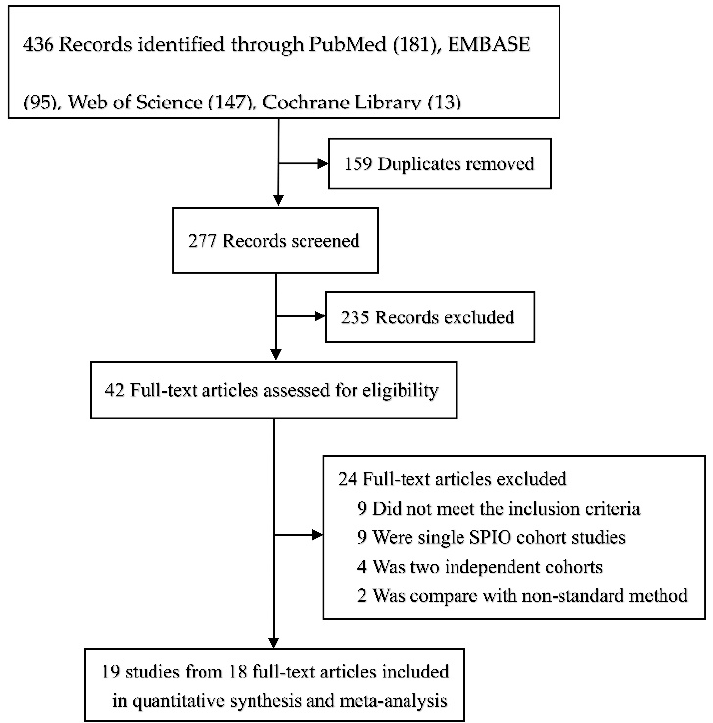
Figure 1. Flowchart depicting the selection process for the inclusion of studies in the article.